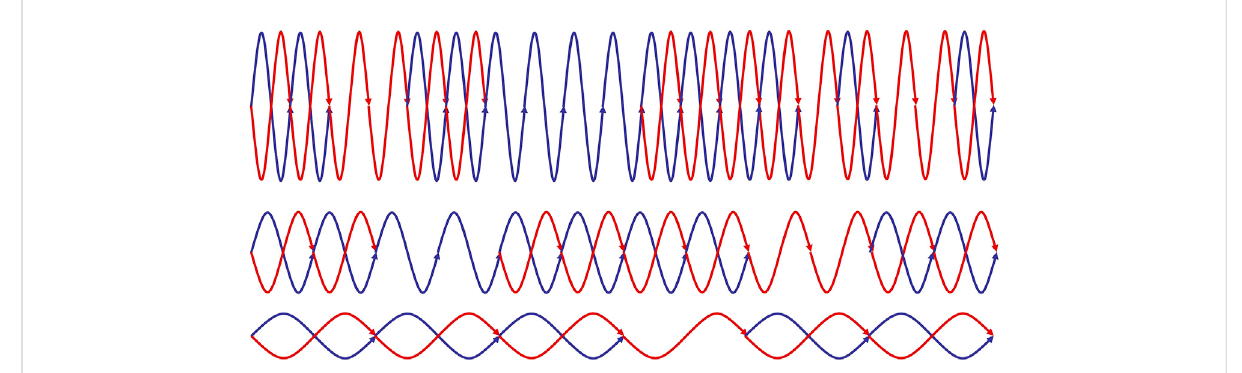
FIGURE 8 The vacuum comprises numerous rays of photons (blue-red waves) with energies, i.e., frequencies or wavelengths that distribute according to the Bose-Einstein statistics. The paired photons cannot be seen as light, but their coupling to the matter, known as mass, is sensed as inertia and gravitation. The unpaired, odd quanta in the rays (blue or red) are visible. Their coupling to matter manifests itself as